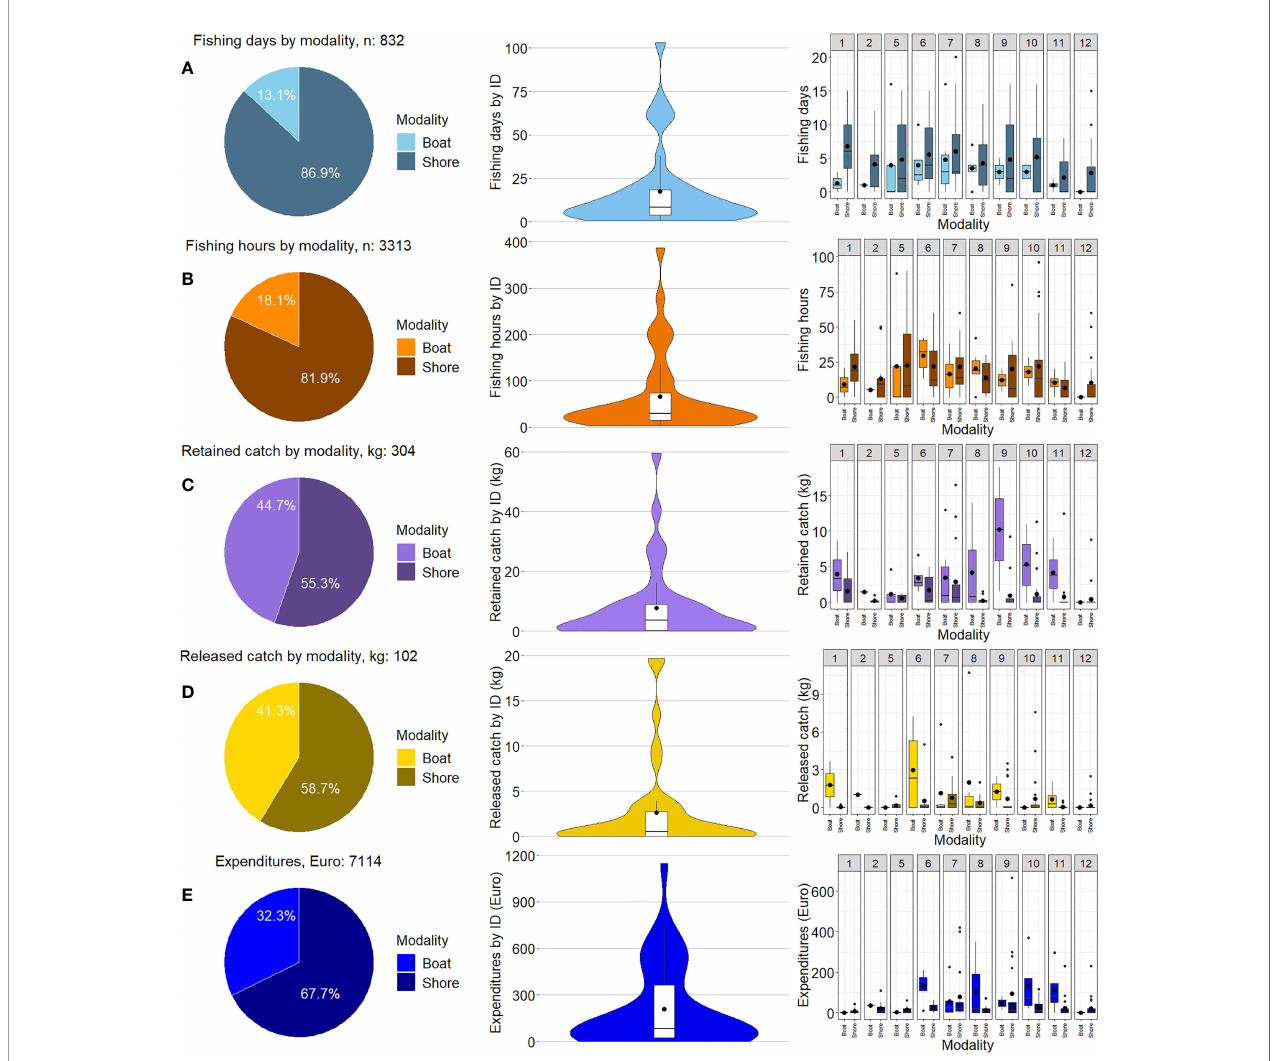
FIGURE 3 | Data on fi shing effort, catches and expenditure from the recall survey in the year 2020. From the left pie chart (n and %), violin plot, and box and whisker plot of variables by modality. From the top: fi shing days (days, A ), fi shing hours (hours, B ), retained catch (kg, C ), released catch (kg, D ), expenditures ( € , E